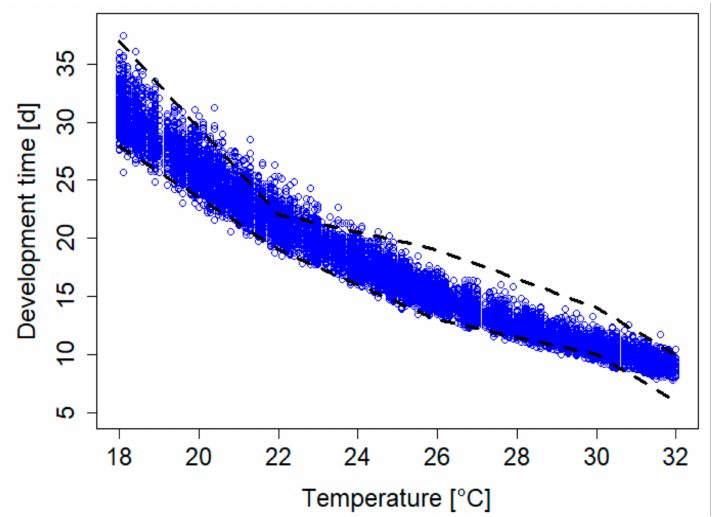
Figure 1. Simulated (dots) and measured range (dashed lines; Du Plessis et al. [8]) of the individual larval development times in days (d) in S. frugiperda .